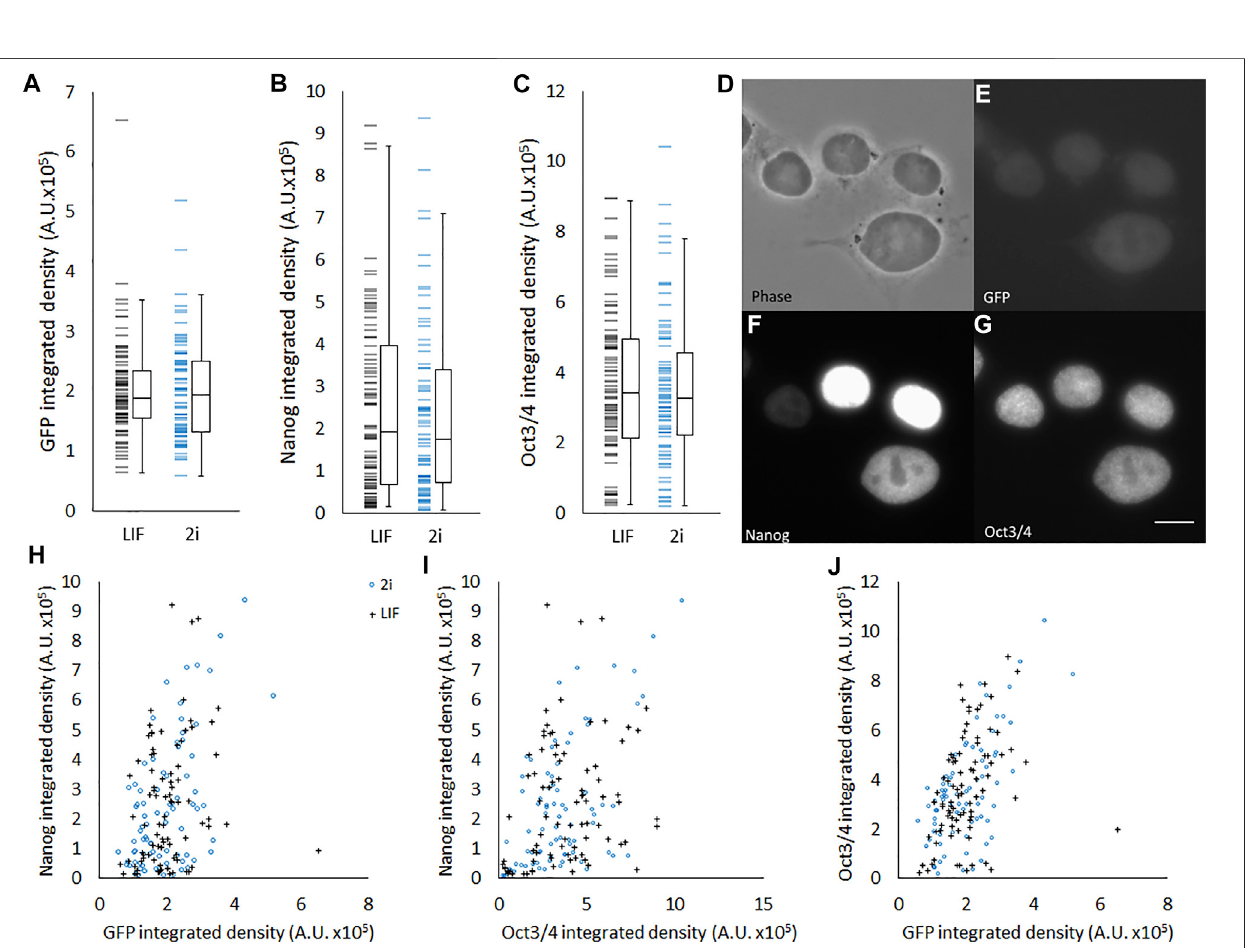
FIGURE 2 | Heterogeneous abundance of Rex1, Oct4, and Nanog in ESCs. Quanti fi cation of 3-colour fl uorescence from individual Rex1-GFPd2 cells immunostainedforNanogandOct4.IndividualvalueplotsofRex1-GFPintensity (A) ,Nanogstainingintensity (B) andOct3/4stainingintensity (C) allrevealconsiderable variance across the population. It is not possible in these data to see differences between cells cultured in 2i ( n = 80) or LIF ( n = 85). Boxes represent median and interquartilerange,withwhiskersextendingto1.5×interquartilerangeorthemax/mindatapoints.Representativeimages (D – G) areincludedtorelatebrightnessof objects to the arbitrary units used in this fi gure. When plotted against each other (H – J) weak correlations are visible. These correlations are quanti fi ed in Table 3 . Scale bar for D – G: 5 µm.